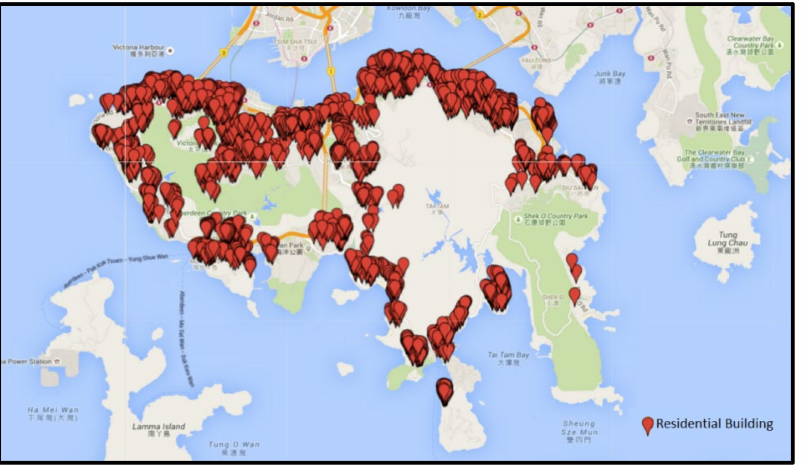
Figure 3. Scatterplot of sample housing units of Hong Kong Island. Source: Google